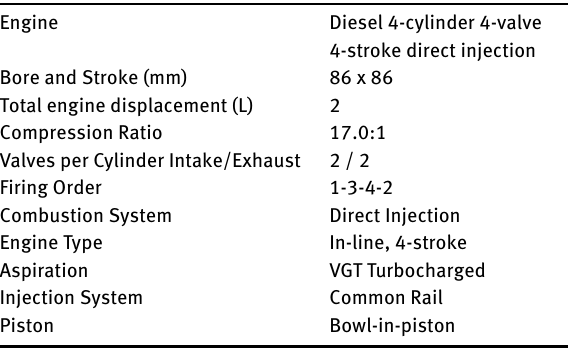
Table 1: Engine Specifications used in GT-Power